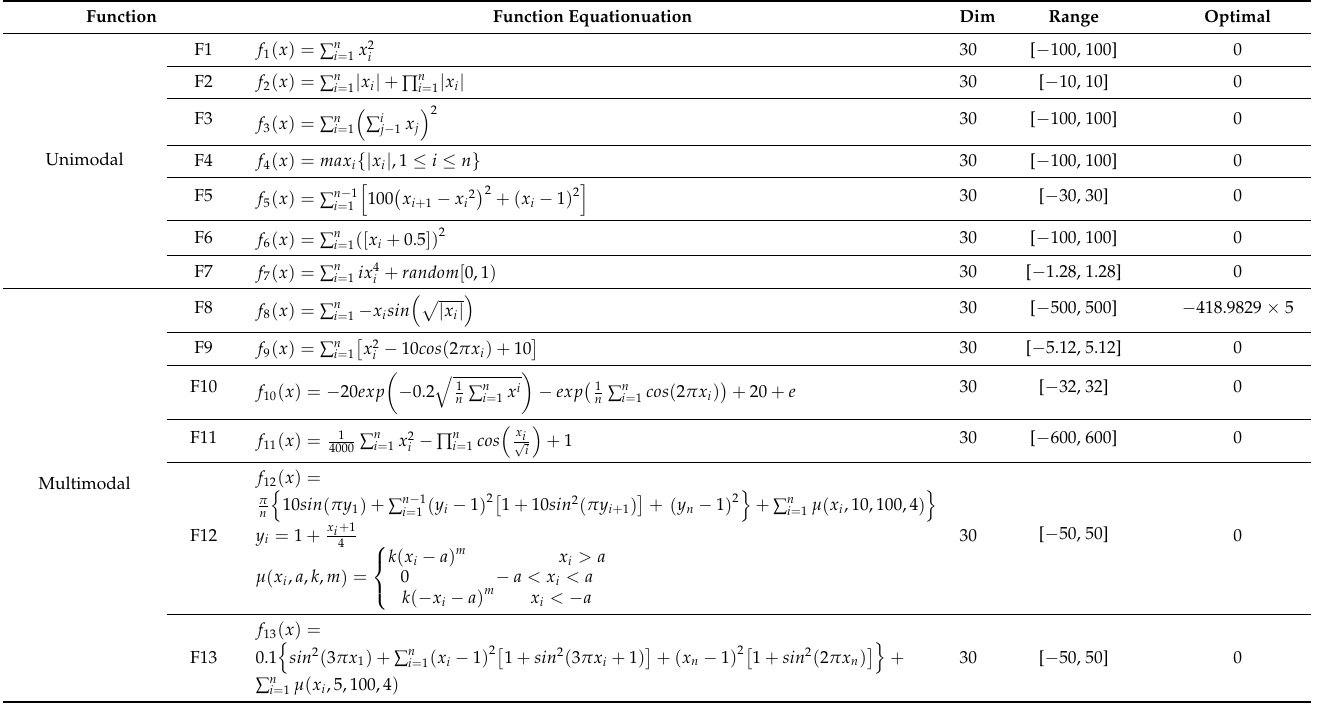
Table 3. Characteristics of the 23 classical benchmark functions